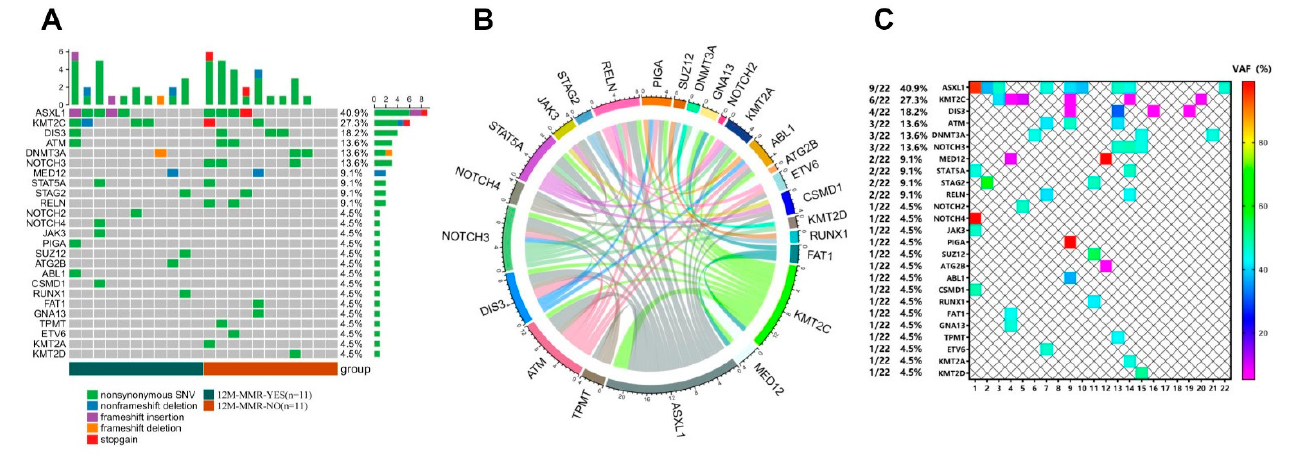
Figure 1. Mutation spectrum in CML-CP patients. ( A ) Type of mutation; ( B ) Co-occurrence of common variants; ( C ) VAF distribution .